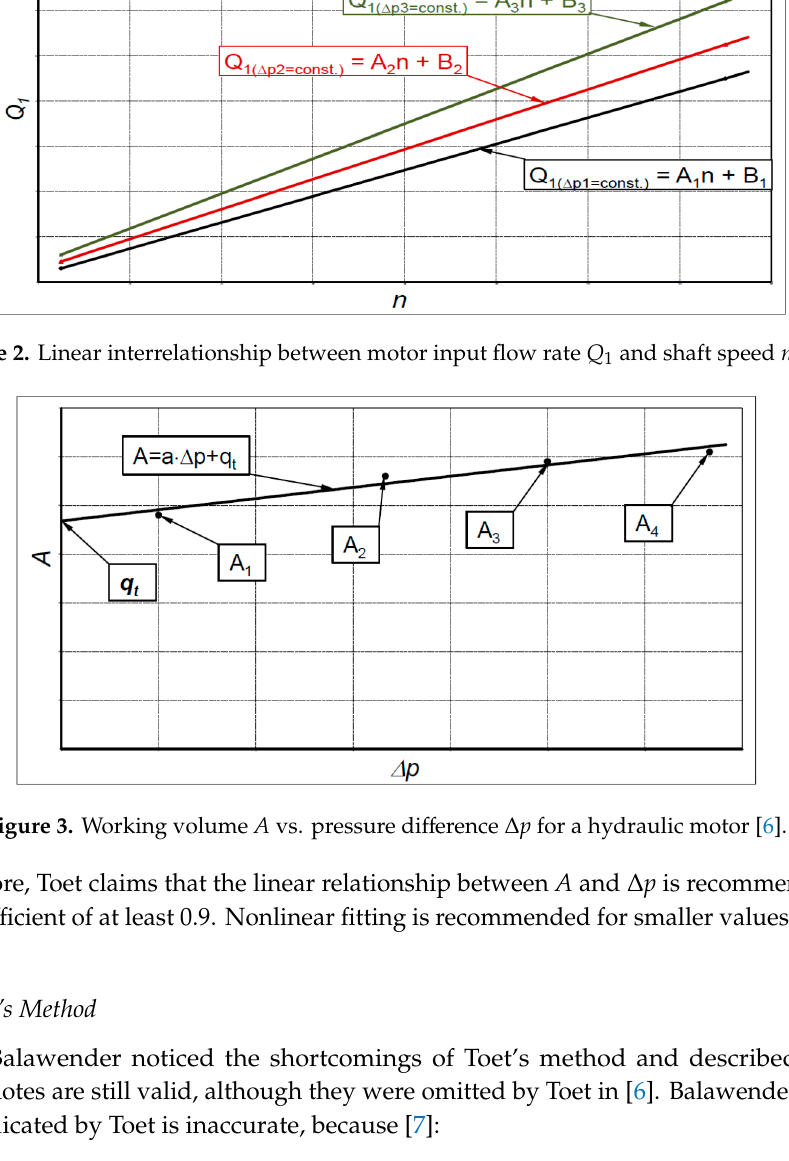
Figure 3. Working volume A vs. pressure difference Δ p for a hydraulic motor [6].